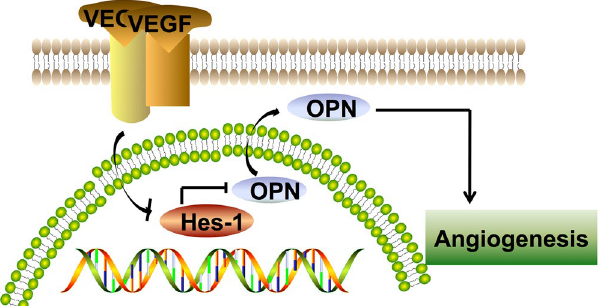
Figure 5. Schematic presentation that highlights the inhibitory effects of Hes-1 on VEGF-induced angiogenesis by targeting OPN gene in atherosclerotic plaques. The results of the present study revealed the following possible mechanism: Hes-1 acted as a transcriptional mediator which inhibited OPN levels. Hes-1 suppressed VEGF-induced angiogenesis via downregulation of OPN